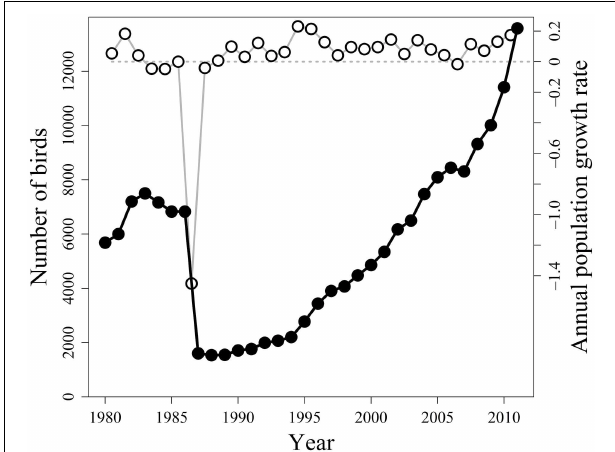
FIGURE 1 | Dynamics of the Common Guillemot population on Hornøya, Northern Norway, from 1980 to 2011. Counts and estimates of numbers of breeding birds (filled circles, left-hand y -axis) and annual population growth rates r (open circles, right-hand y -axis). Figure adapted from Erikstad et al.